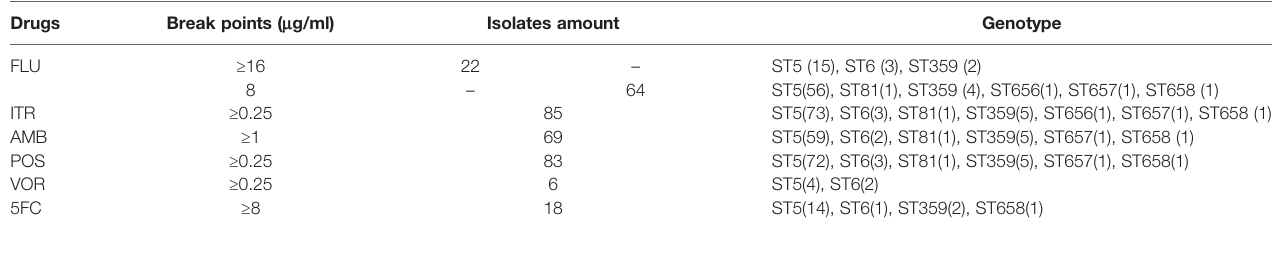
TABLE 3 | The results of the in vitro tests of six antifungal drugs in 86 fl uconazole-resistant isolates. Drugs Break points ( m g/ml) Isolates